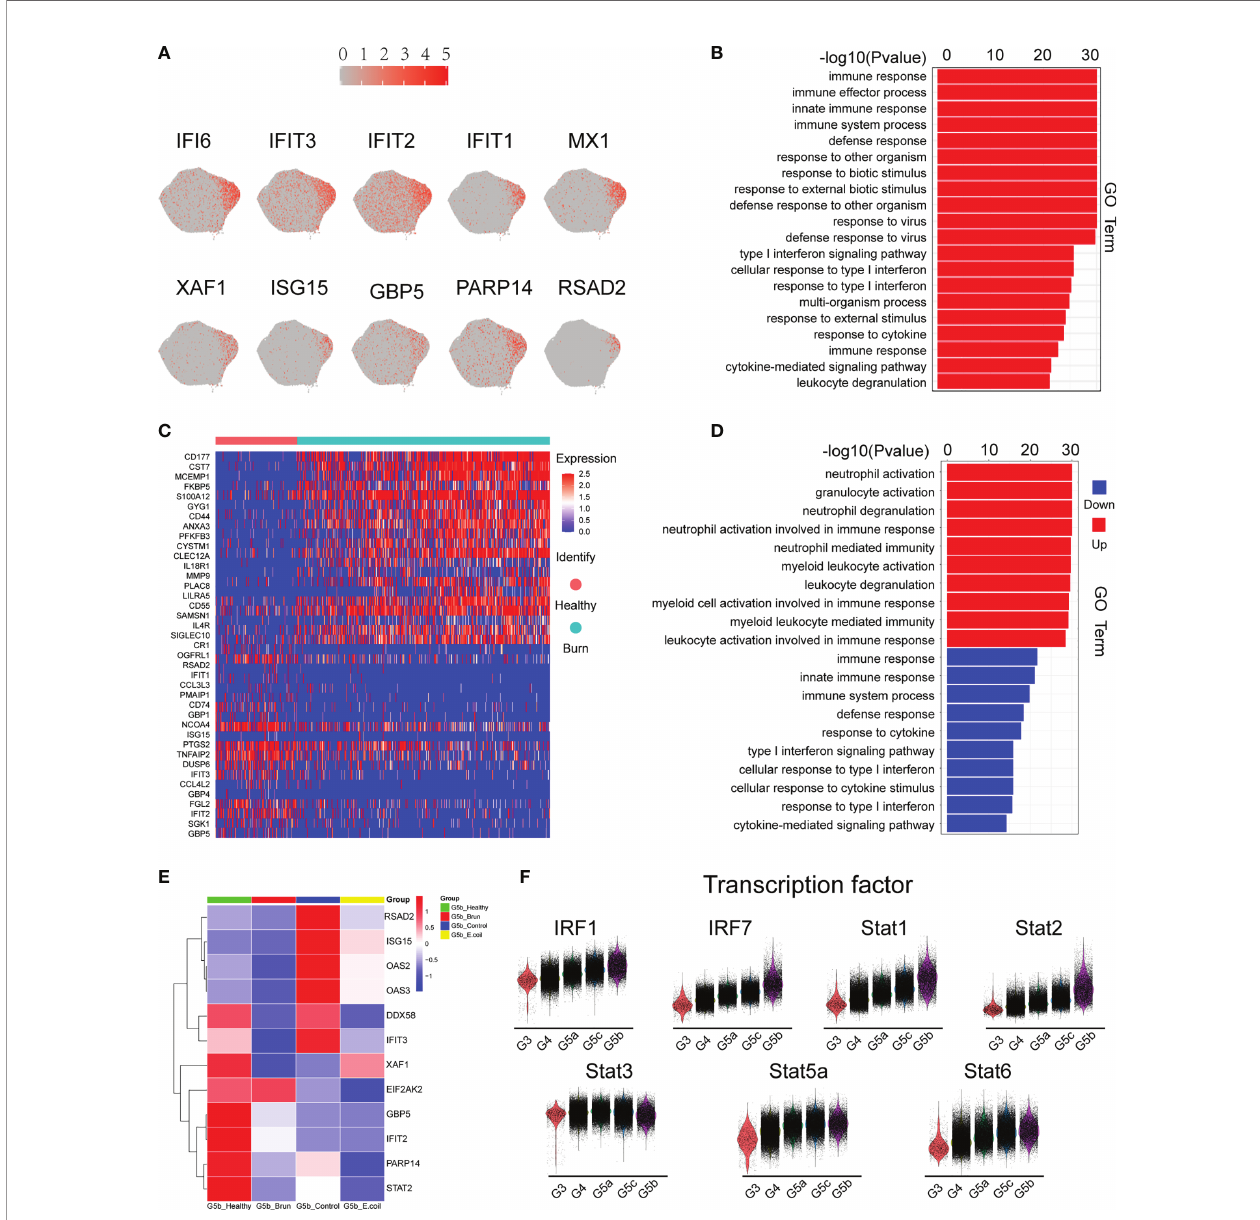
FIGURE 4 | Characteristics of the G5b subgroup. (A) Speci fi c genetic markers for the G5b subgroup. (B) Gene Ontology analysis of DEGs for the G5b subgroup compared with the other four subgroups. (C) Heatmap of differentially expressed genes in healthy and burned patients. (D) GO analysis (BP) of differential genes in healthy and burned patients. Red represents up-regulated differentially expressed gene cluster entries, and blue represents down-regulated differentially expressed gene cluster entries. (E) Heatmap of ISG gene expression in G5b of our study was compared with that of Xie et al. (F) Violin plot of characteristic transcription factors in the G5b